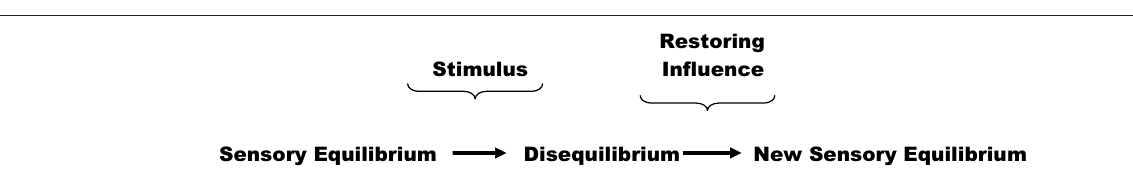
Figure 2 | Le Chatelier–Braun principle extended to sensory function.